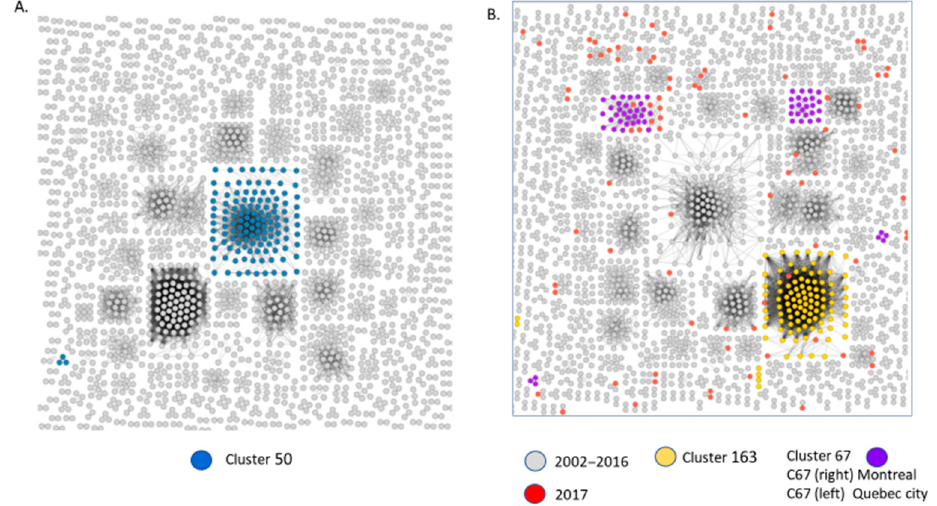
Figure 4. HIV-Trace resolution of clustered MSM networks (2002–2017). Network inferences depict clusters having 2 or more linked sequences at a 1.5% genetic distance. ( A ) Cluster 50 members ( n = 142), coloured in blue, segregated as a large cluster ( n = 125) and a triad ( n = 3). ( B ) New infections added in 2017, coloured in red, were added to pre-existent clusters from 2002–2016, shown in grey; Cluster 163 ( n = 122), depicted in yellow, increased by 5. Cluster 67 segregated into two clusters: a sub-epidemic circulating in Quebec City (left) and Montreal (right). Quebec City increased by 9 members in 2017.